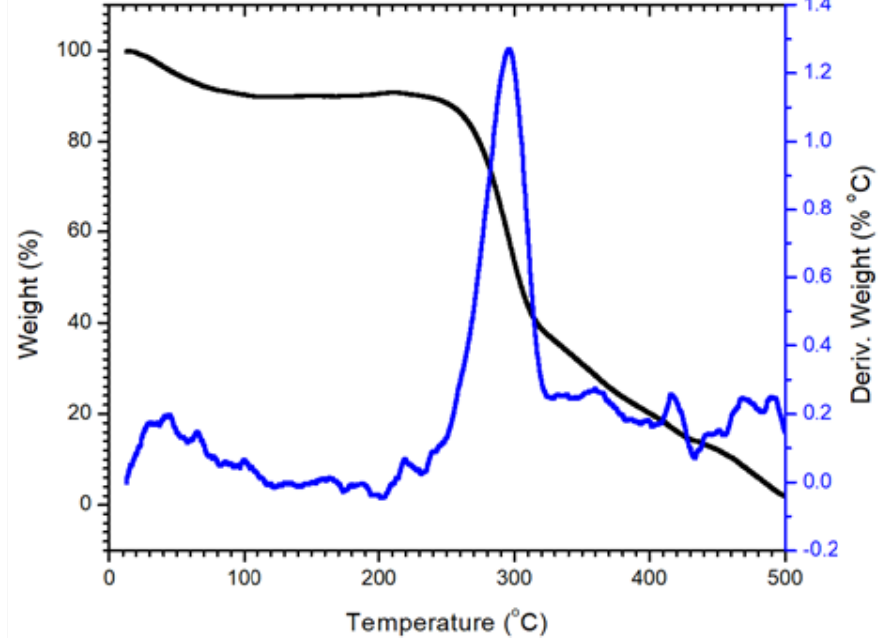
Figure 6. Thermal analysis TG and DrTGA for cellulose at 20 – 500 °C.